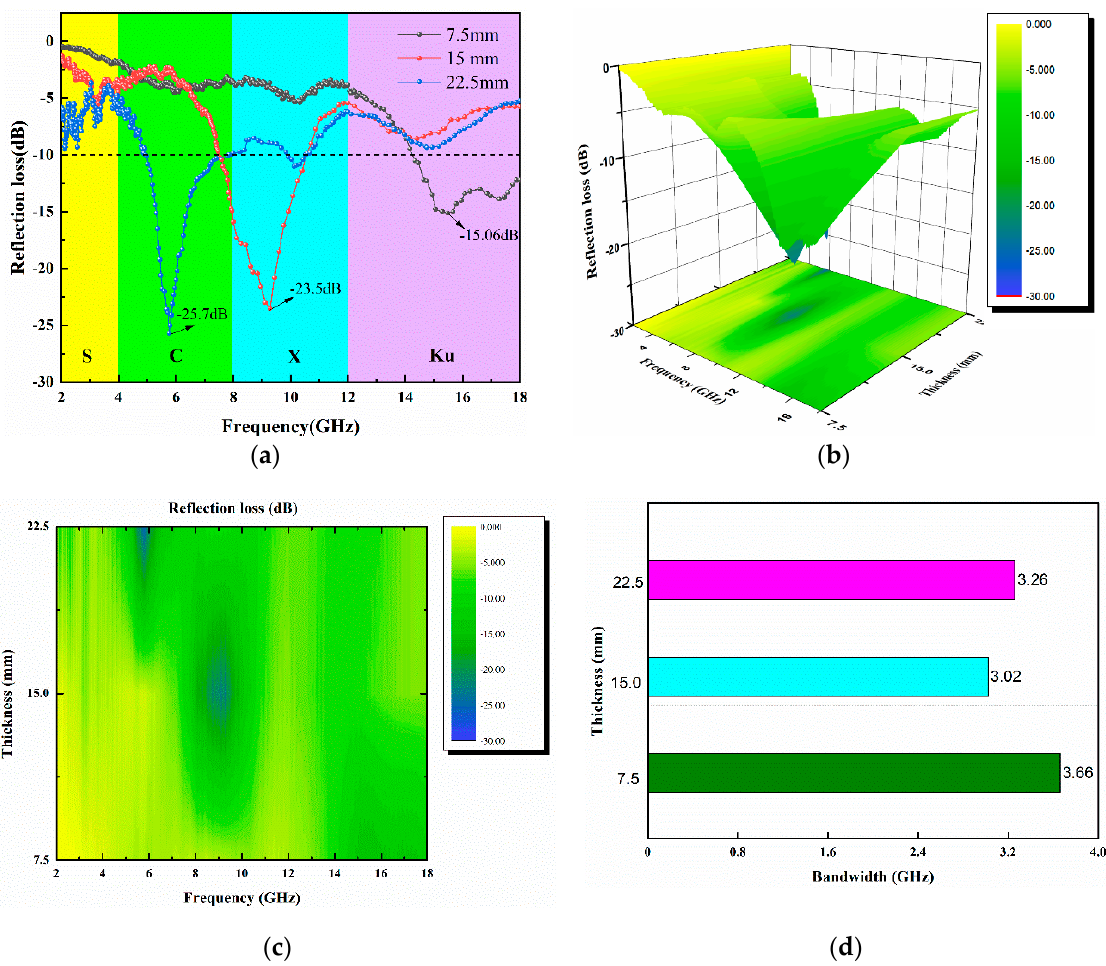
Figure 8. ( a ) RL curves of S1, S2, S3; ( b ) 3-D RL of S1, S2, S3; ( c ) two-dimensional plane RL of S1, S2, S3; ( d ) EAB of S1, S2, S3.